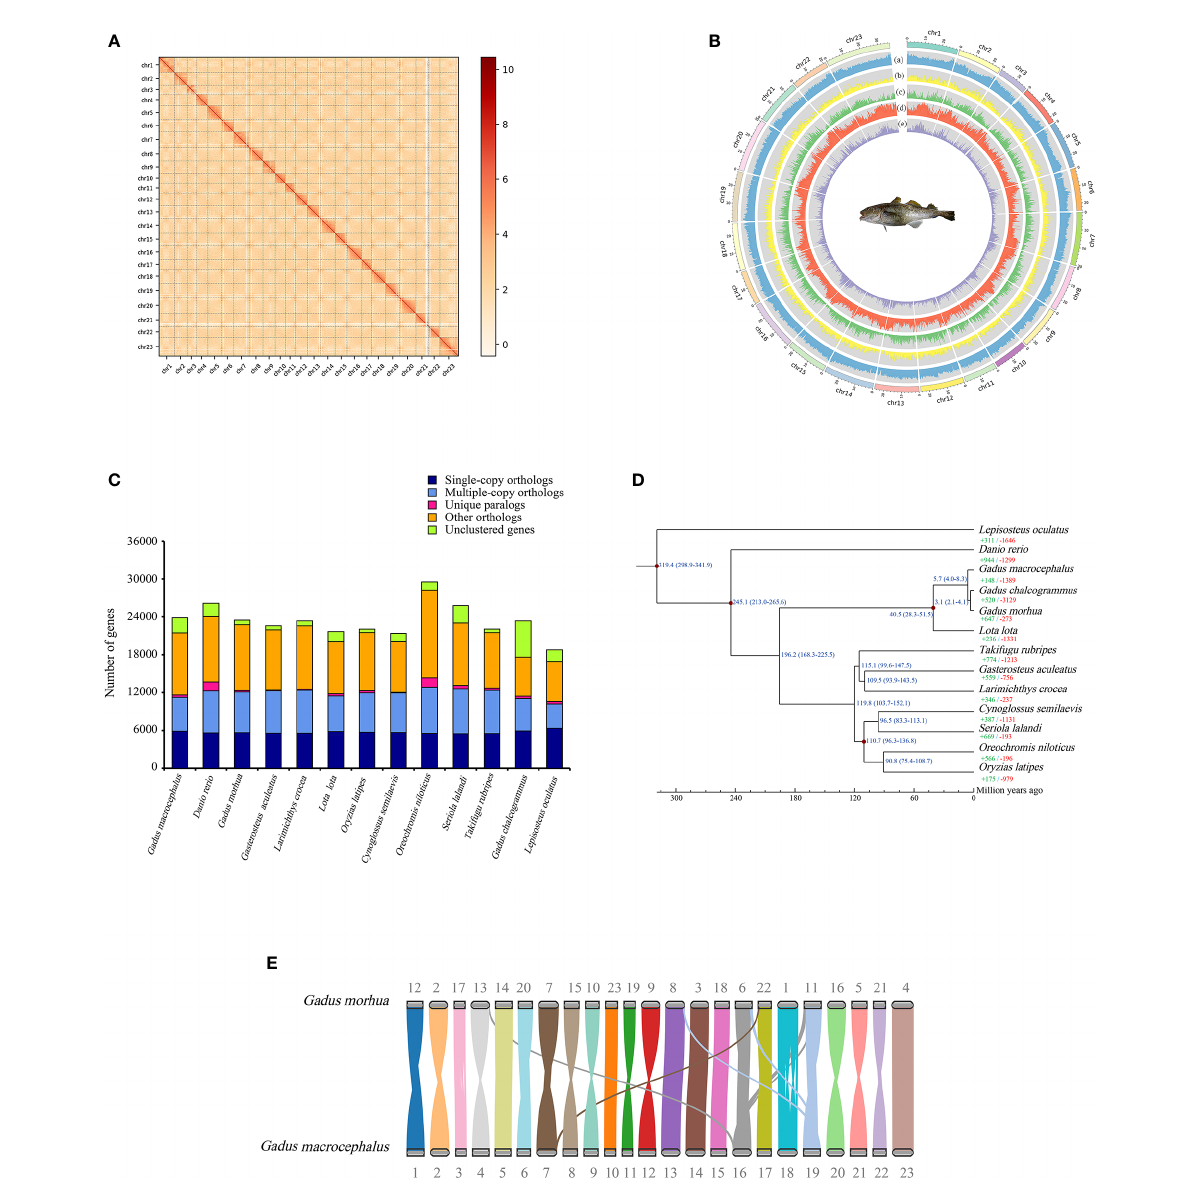
FIGURE 1 Characteristics of genome and summary of comparative genomics analysis. (A) 23 chromosomes of G . macrocephalus were obtained from genome assembly. (B) Statistics of genome annotation of G . macrocephalus . From outside to inside, the results correspond to: (a) GC content; (b) gene density; (c) CDS content; (d) repetitive sequence content; (e) LTR content. (C) Ortholog clustering results among 13 species. (D) Phylogenetic analysis of 13 species and analysis of gene family expansion and contraction. The red dots on the branches indicated the calibration points. The divergence time of 13 species was showed on the branches with blue numbers (Mya). The green and red numbers indicated the expanded and contracted gene families, respectively. (E) Genome synteny between G . macrocephalus and G .